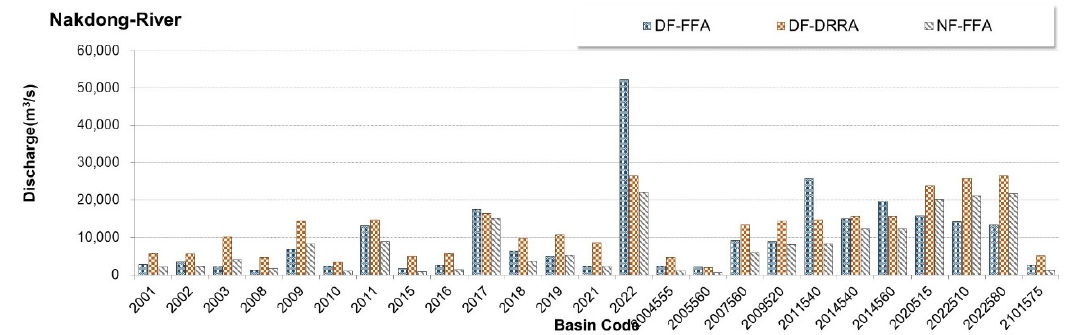
Figure 10. The 100-year design floods of Nakdong River basin.